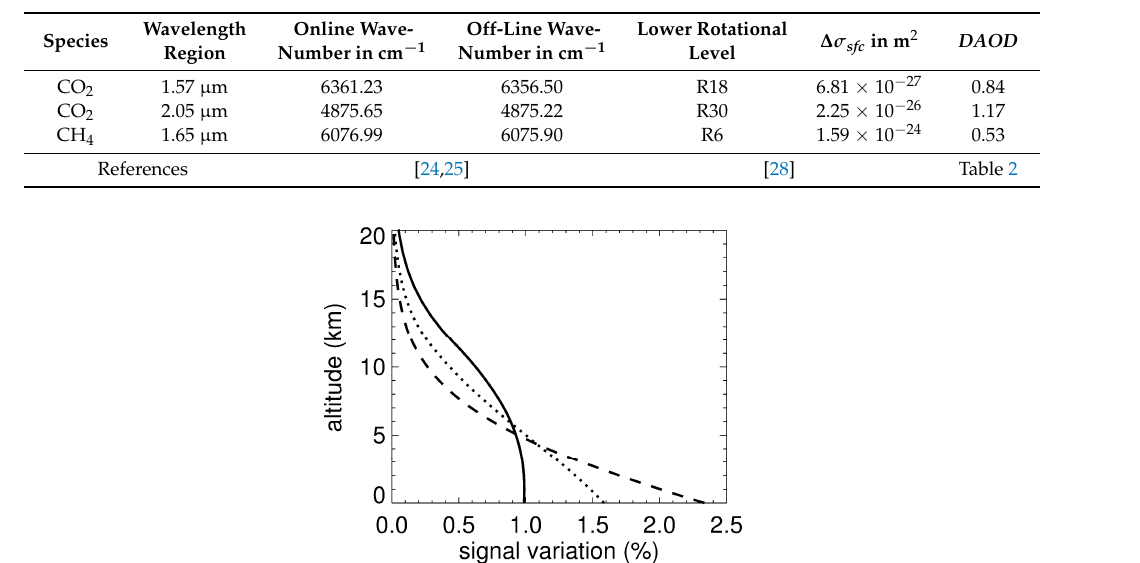
Table 1. On- and offline space Lidar wavenumber positions selected for CO 2 and CH 4 . The lower rotational level denotes the selected molecular absorption lines. The most recent HITRAN 2016 spectroscopic data [28] were used to calculate the differential absorption cross section ∆ σ sfc at mean sea level. The total columnar one-way DAOD is determined by Equation (1) using the environmental parameters of Table 2.